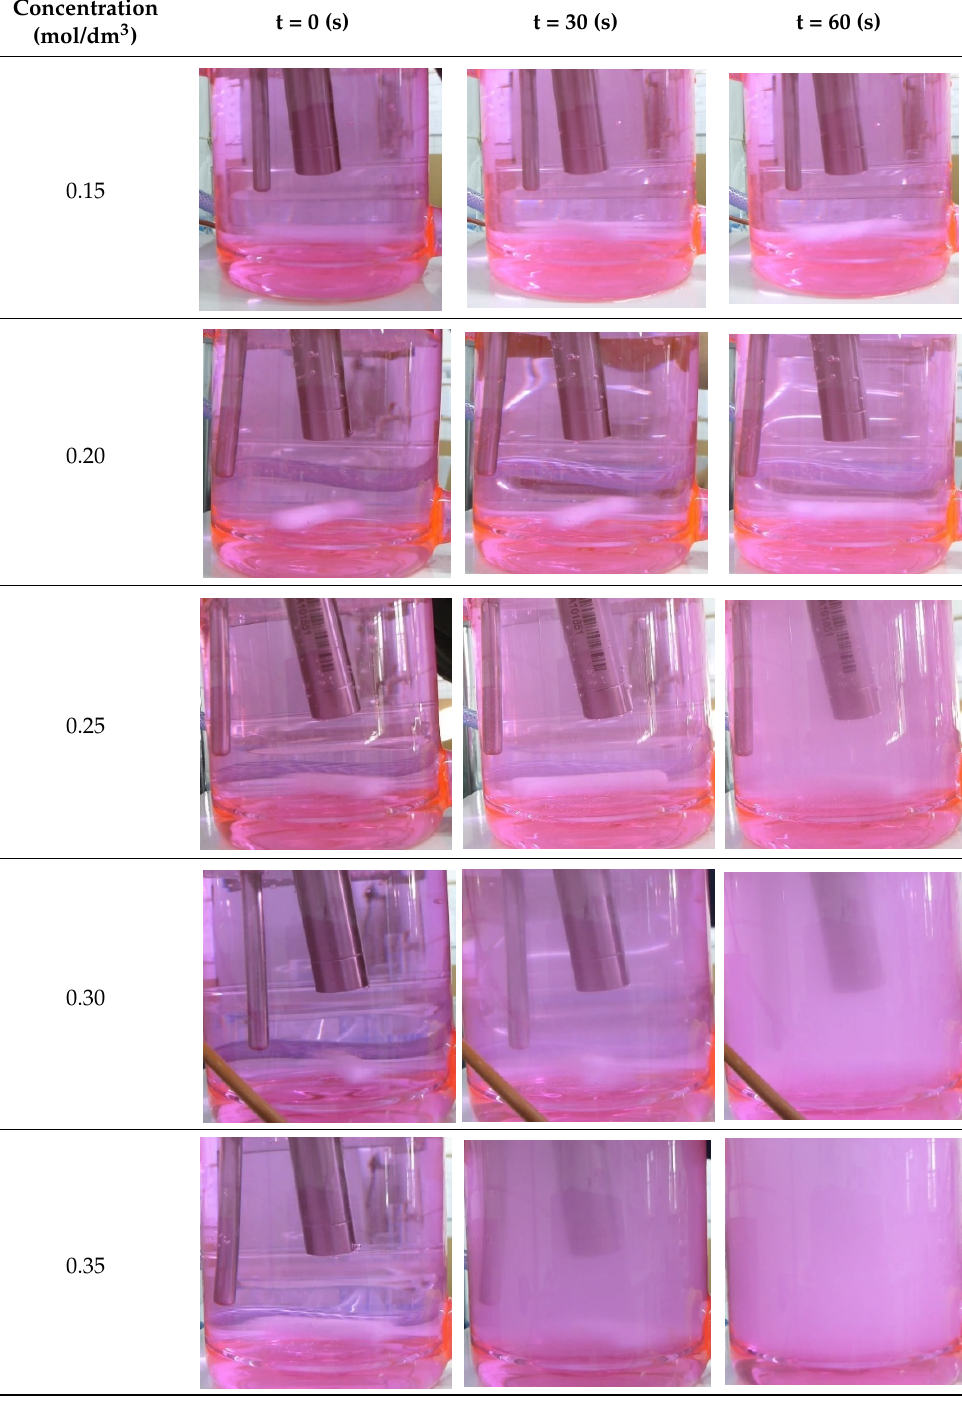
Table 3. Comparison of turbidity of solution during precipitation for various concentrations.